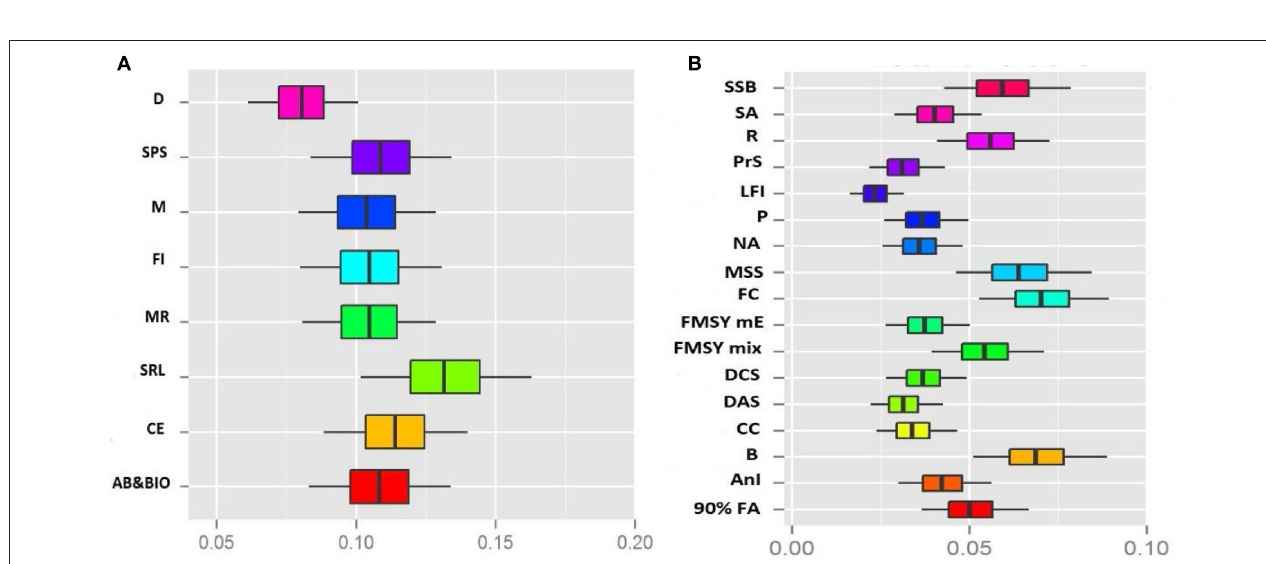
FIGURE 5 | Survey 1—AHP (Ranking preferences): Ranking the objectives with uncertainty (box plot with median and percentile values: 0.05, 0.25, 0.75, and 0.95). (A) Level 1, D, Reduce discards; SPS, Preserve the size structure of the fish populations; M, Monitoring the mortality; FI, Monitoring the fishing intensity; MR, Maximize revenue; SRL, Maintain safe level of reproductive potential; CE, Improve cost efficiency; AB&Bio, Conserve abundance and biodiversity. (B) Level 2, SSB, Spawning stock biomass; SA, Spawning areas; R, Revenue; PrS, Proportion of elasmobranchs; LFI, Proportion of large fish; P, Production; NA, Nursery areas; MSS, Mean size of the spawners; FC, Fuel cost; FMSY mE, Fishing mortality at the MSY of the most exploited species; FMSY mix, Fishing mortality at the MSY of a mix of target species; DCS, Discard rate of commercially exploited species; DAS, Discard rate of all the exploited species; CC, Crew cost; B, Biomass of all species; AnI, Area not impacted by fishing gears; 90% FA, Area in which 90% of the fishery by metier, month, and year